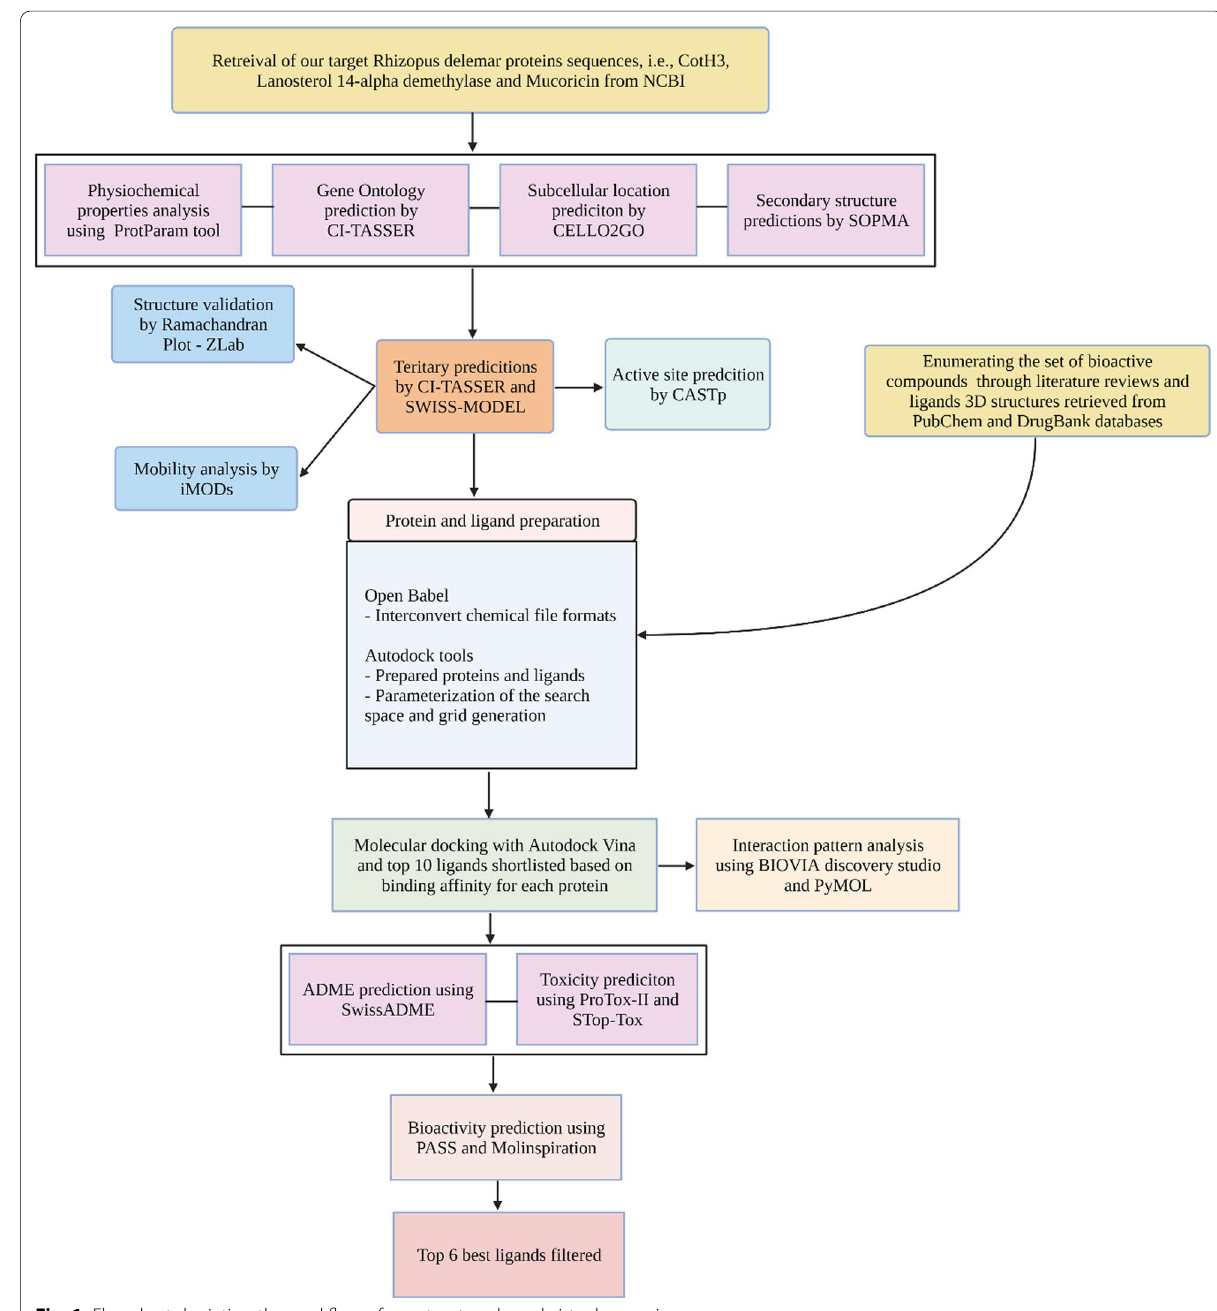
Fig. 1 Flowchart depicting the workflow of our structure-based virtual